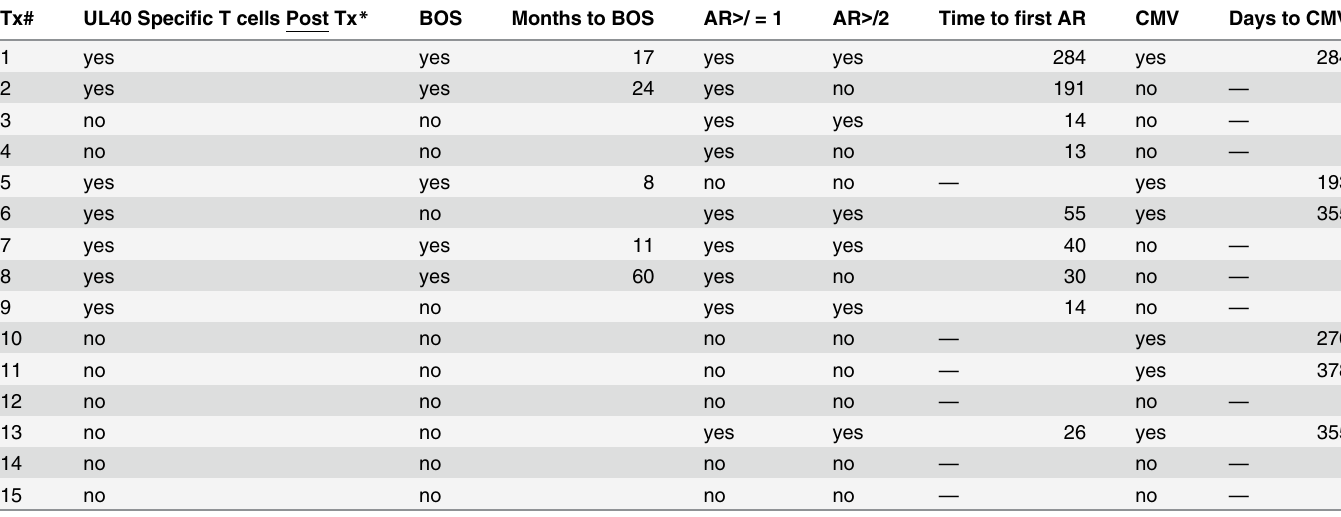
Table 2. Clinical Complications post Lung